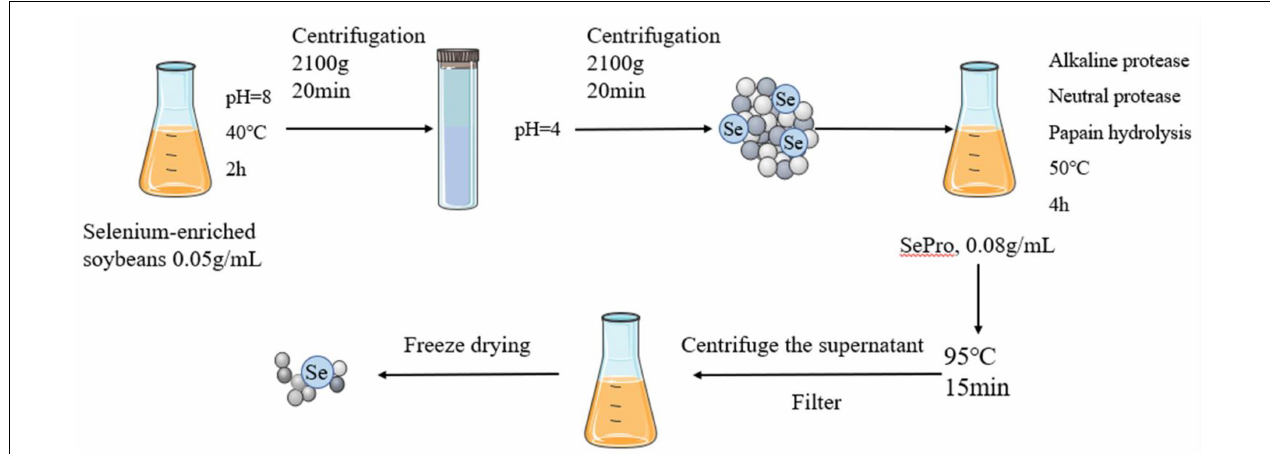
FIGURE 1 | Preparation of